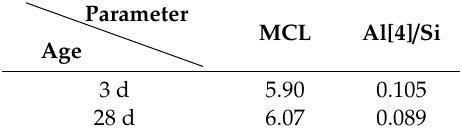
Table 3. Molecular chain length (MCL) and Al[4]/Si at different